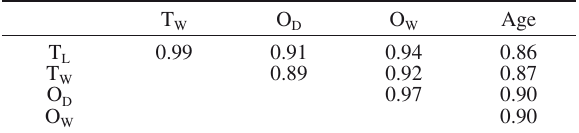
Table 3. – Pairwise Spearman rank correlation coefficients of morphometric characteristics and age of juvenile sardines from the